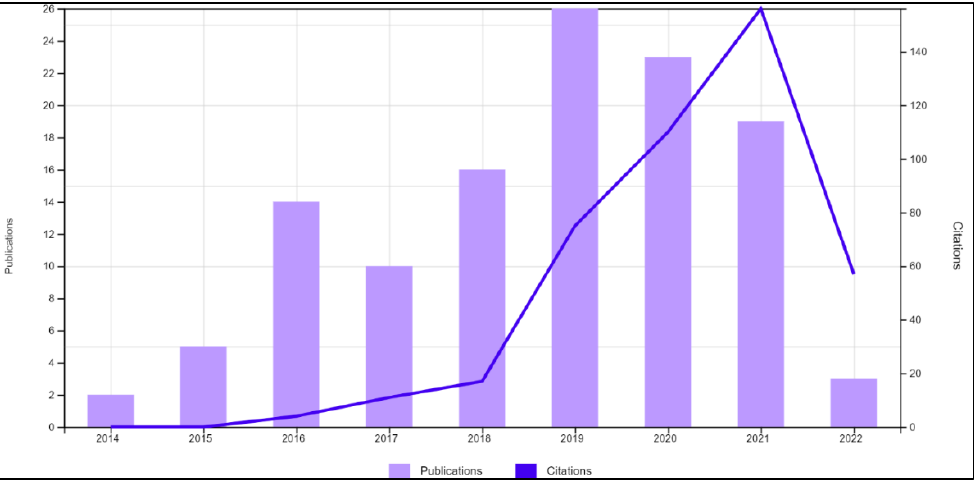
Figure 8. An overview of publications and citations on the topic of Smart cities in Slovakia. Source: own analysis as per Web of Science (2022).